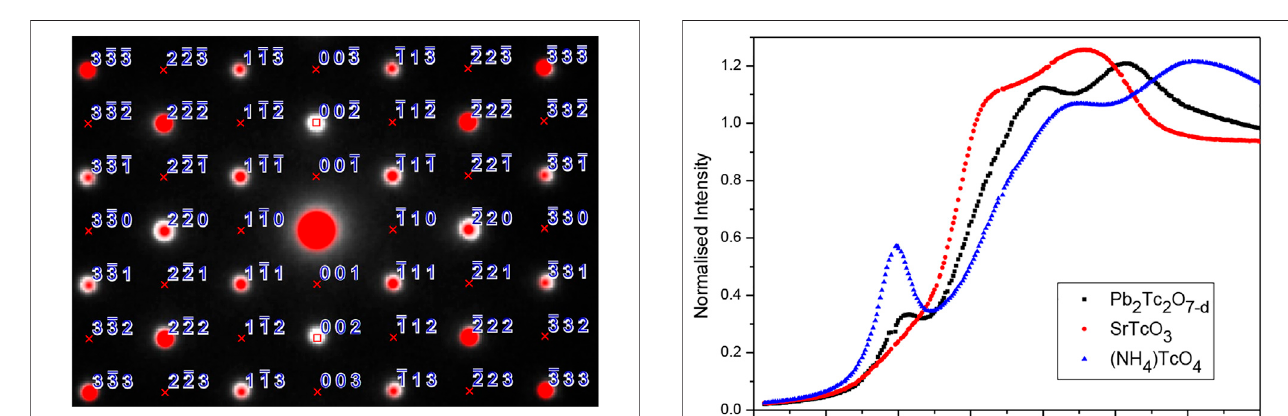
FIGURE 3 | SAD pattern with experimental data shown as white dots, red dots indicate the simulated pattern, re fl ections are marked, lattice absences are shown with a red cross and space group absences are shown with a red square.